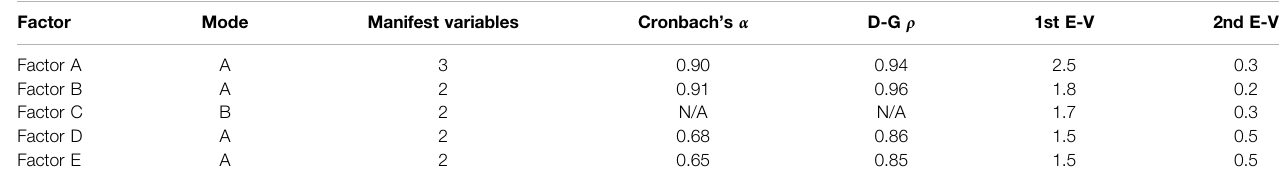
TABLE 2 | Measures of unidimensionality from the PLSPM analysis, by factor. Re fl ective (A) or formative (B) relationships to variables are listed, as well as the number of manifest variables assigned to each factor. The unidimensionality statistics, Cronbach ’ s alpha, Dillon-Goldstein ’ s rho, and the fi rst and second eigenvalues are given for the re fl ective